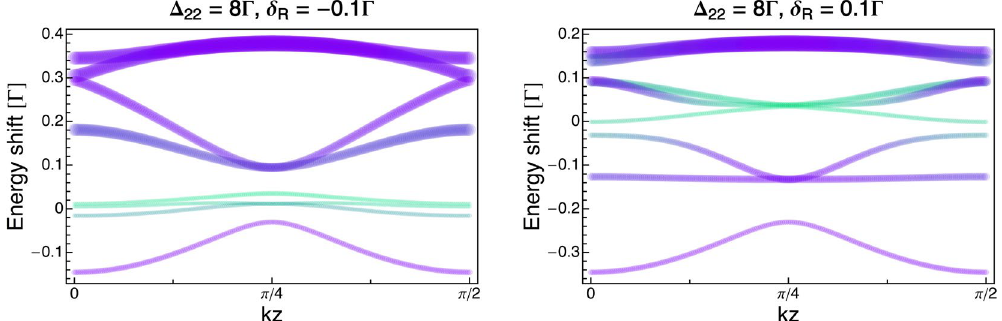
Figure 6. Energy of low-scattering states as a function of position. Purple(green) lines are states with dominant weight in F = 1(2) level; for each state considered, the values plotted in graph are the energy shifts with respect to the corresponding level energy in the absence of the light. The line thickness is proportional to position- dependent scattering rate γ ′ defined in text. Left: Energies calculated for δ R = − 0.1 Γ ; Right: energies calculated for δ R = + 0.1 Γ